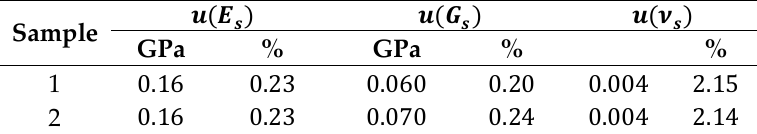
Table 3. Uncertainties on the glass substrate elasticity constants obtained by IET. Sample